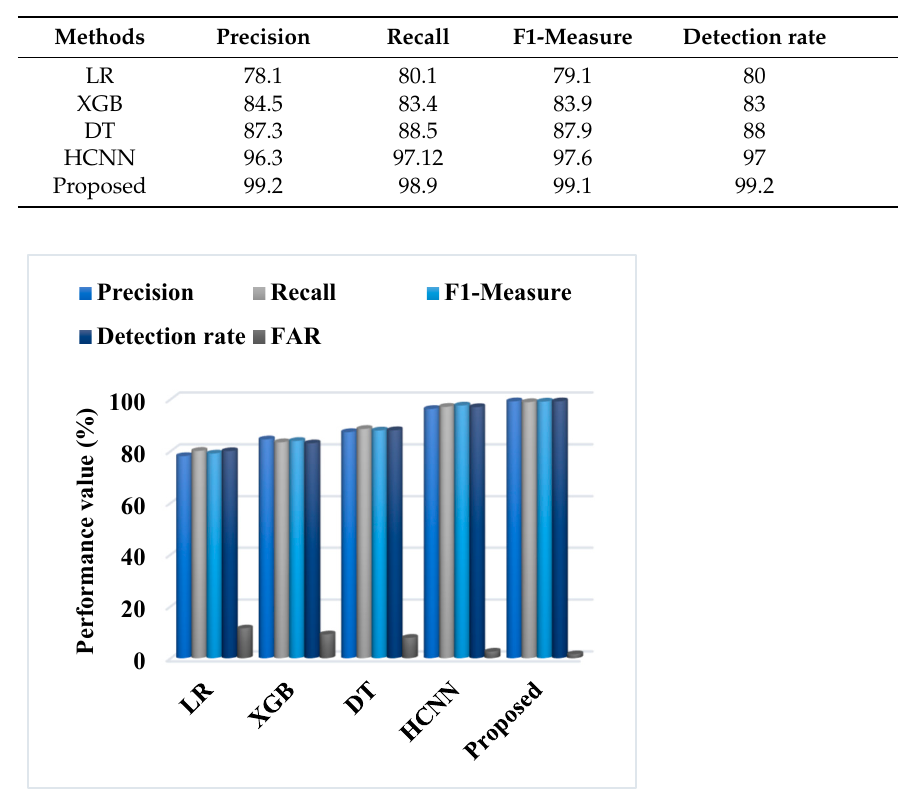
Figure 19. Performance analysis using dataset 3.